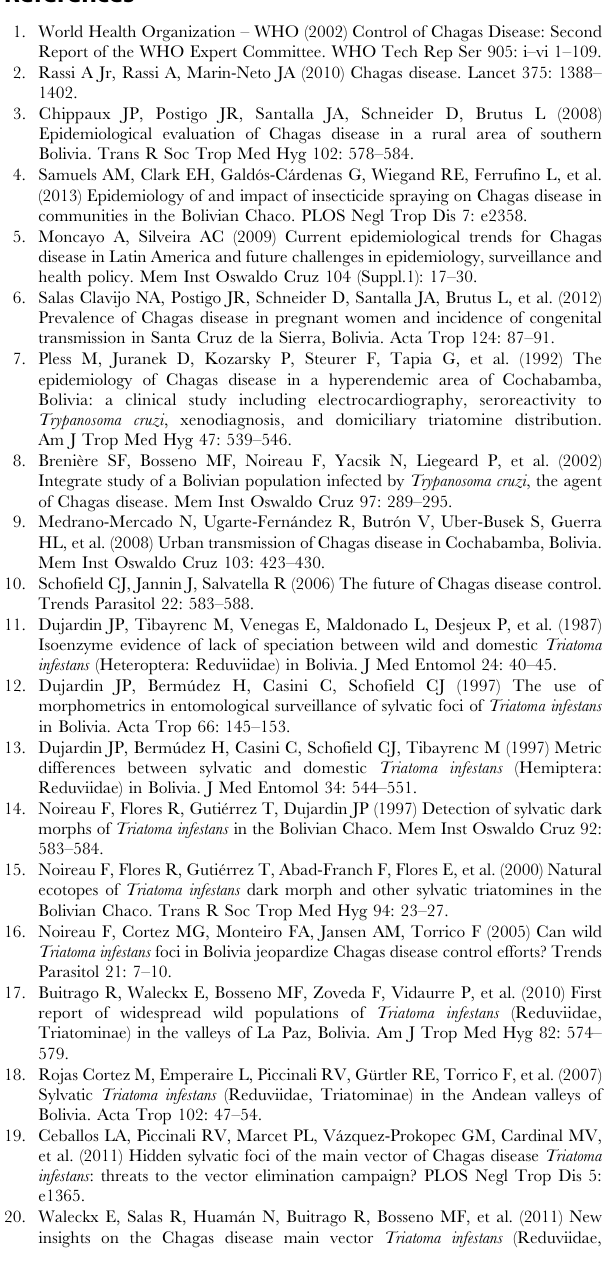
Table S2 Triatomine bugs collected during the activities of the Chagas Disease Control Program of the Department of Cocha- bamba, Bolivia, 2007–2010. Table S3 Municipalities with recorded dwelling infestation by triatomine bugs equal to zero in Chagas disease risk areas, Cochabamba, Bolivia,